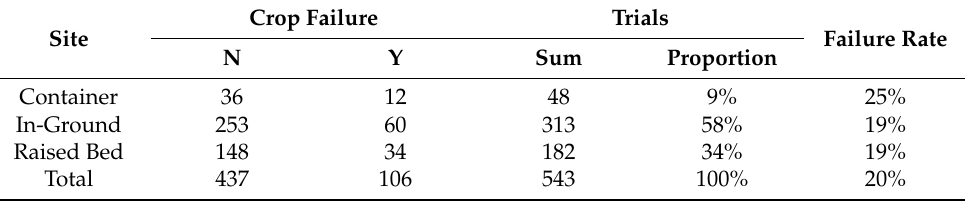
Table 5. Crop failure rate (N = no, Y = yes) by trial site as self-reported by trial participants in 2019 and 2020. Categorical analysis of crop failure by site was not significant at an alpha level of 0.1 ( p = 0.8090).